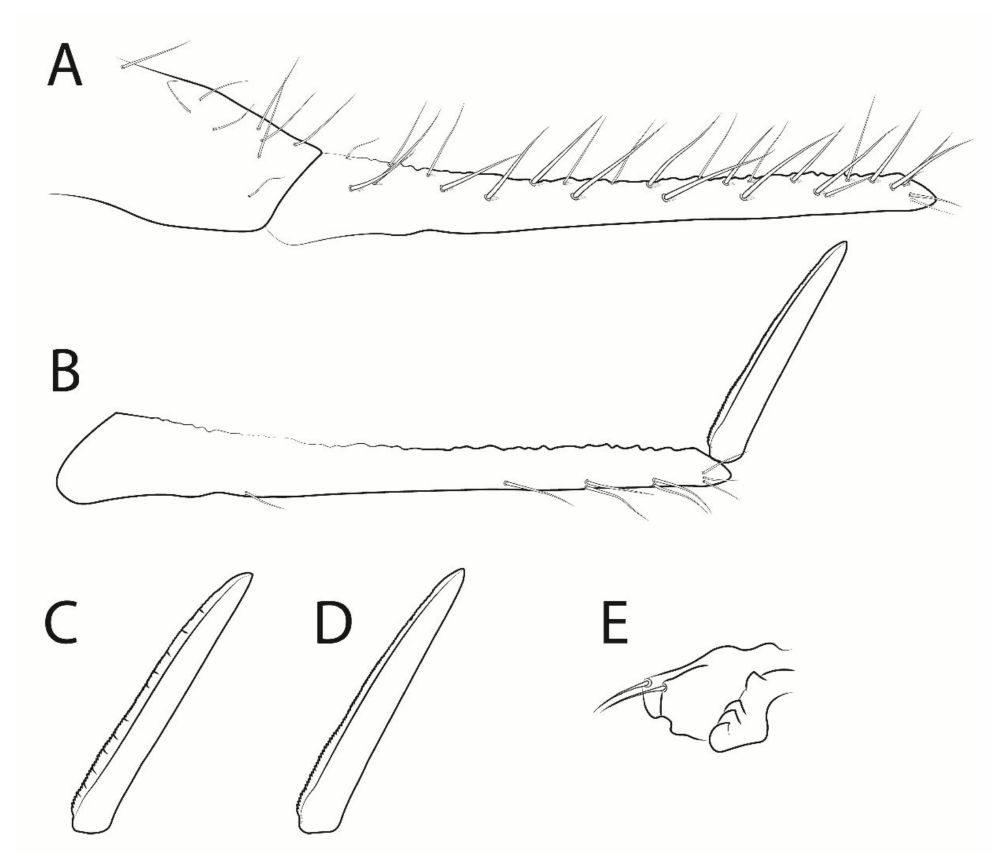
Figure 9. Troglobentosminthurus luridus gen. nov. sp. nov. furcula: ( A ) dorso-lateral view of the manubrium and dens; ( B ) ventro-lateral view of the left dens and mucro of a female; ( C , D ) sexual dimorphism regarding the mucro: ( C ) lateral view of the left mucro of a male; ( D ) lateral view of the left mucro of a female; ( E )